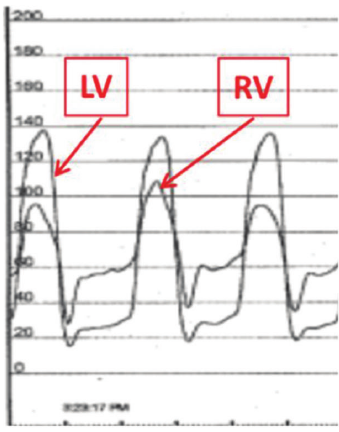
Figure 3: Hemodynamics during right heart catheterization show- ing persistence ventricular interdependence between the left ventri- cle (LV) and the right ventricle (RV) after evacuation of pericardial